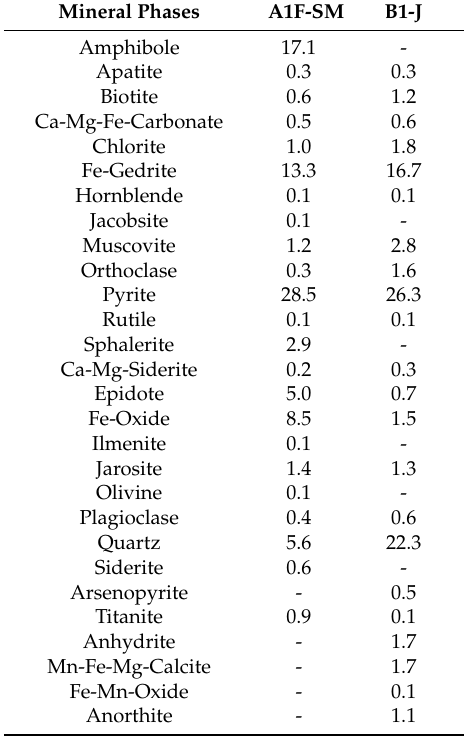
Table 4. Mineral content of A1F-SM in wt %, determined using mineral liberation